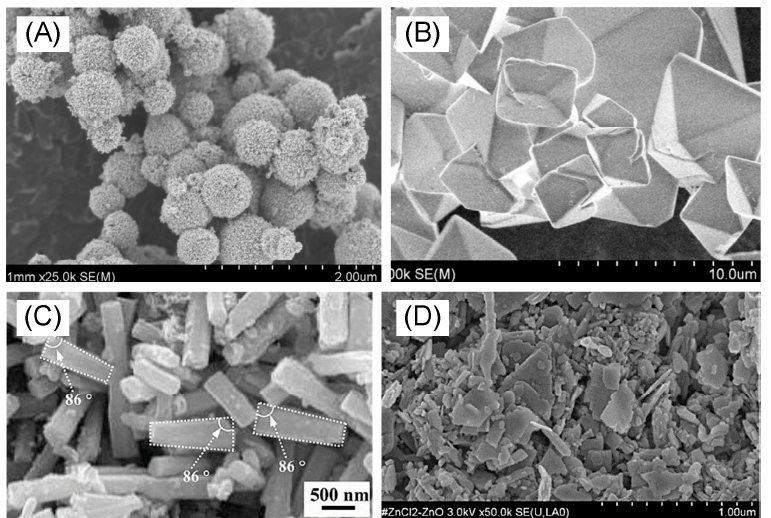
Figure 8. Scanning electron microscopy (SEM) morphology of ZnO nanoparticles ( A ) spherical ZnO, ( B ) bicone ZnO, ( C ) hexagonal sectional ZnO, ( D ) ZnO plates [97]. ( B ) bicone ZnO, ( C ) hexagonal sectional ZnO, ( D ) ZnO plates